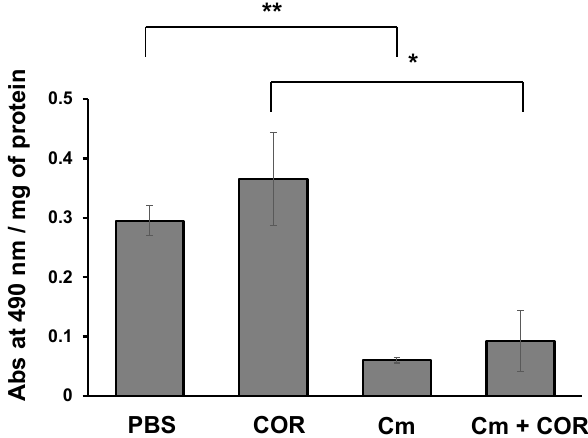
Figure 6. PO activity in hemolymph of silkworm larvae. Assay of PO activity used hemolymph of Scheme 72 h after injection. Cm and COR denote C. militaris and cordycepin, respectively. Data were analyzed by an unpaired Student’s t -test. The difference was assessed with two-side test. ( n = 3). * p < 0.05, ** p <